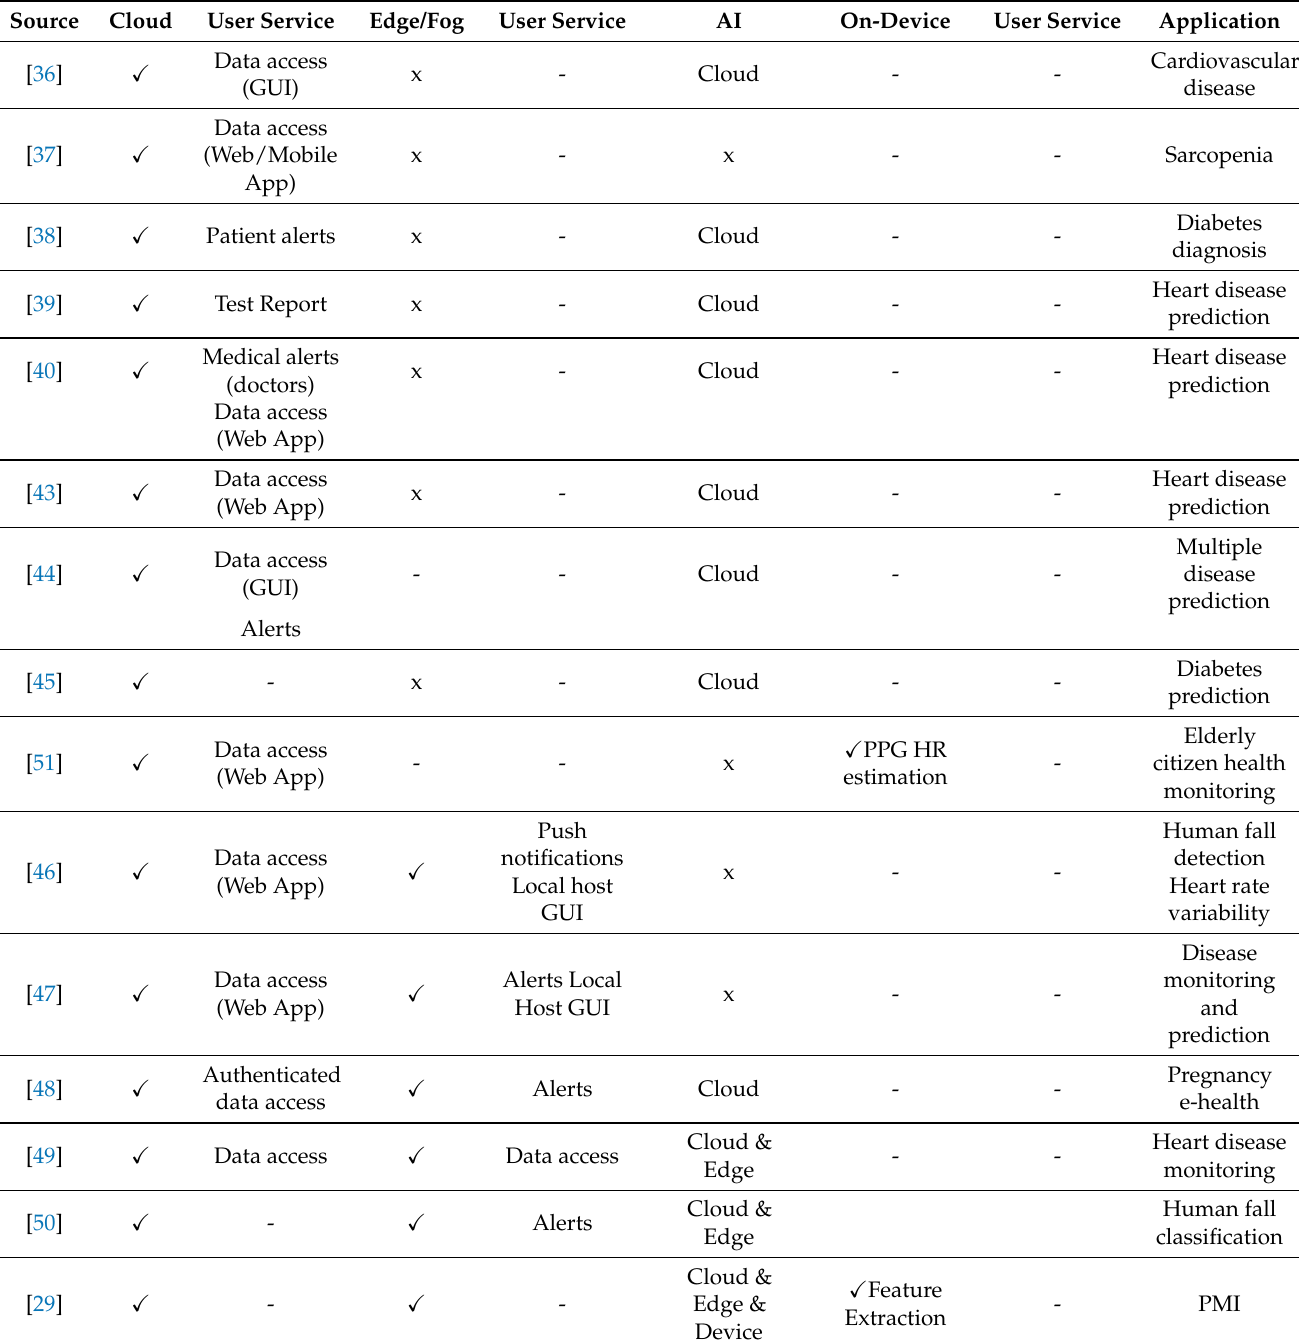
Table 1. Comparative analysis: Existing